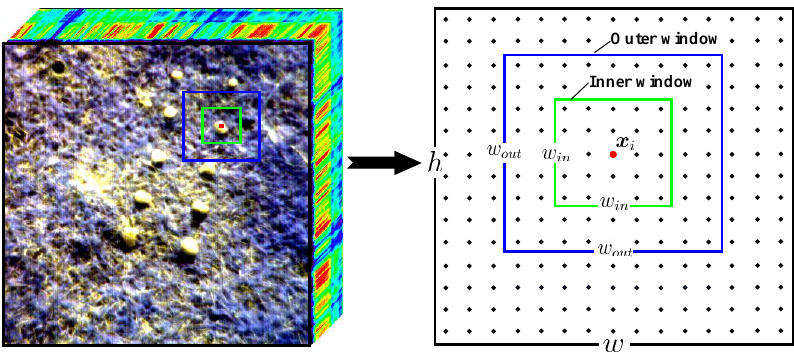
Figure 1. The sliding dual window of the collaborative representation-based detector